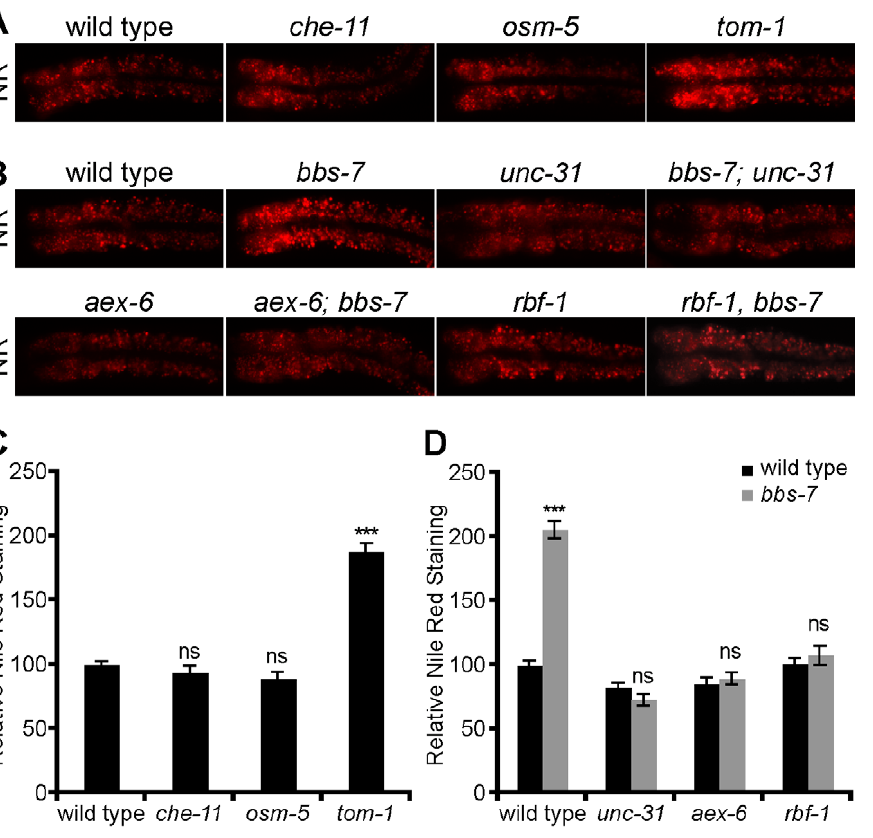
Figure 6. Enhanced secretion caused metabolic defect in bbs mutants. Representative images (A, C) and quantitation with standard error (B, D) of Nile Red staining in the first pair of intestinal cells of bbs-7 , IFT, and dense-core vesicle secretion mutants (*** p , 0.001; ns , not significant, compared to wild type in B or comparing double mutants to the corresponding single mutant in D).